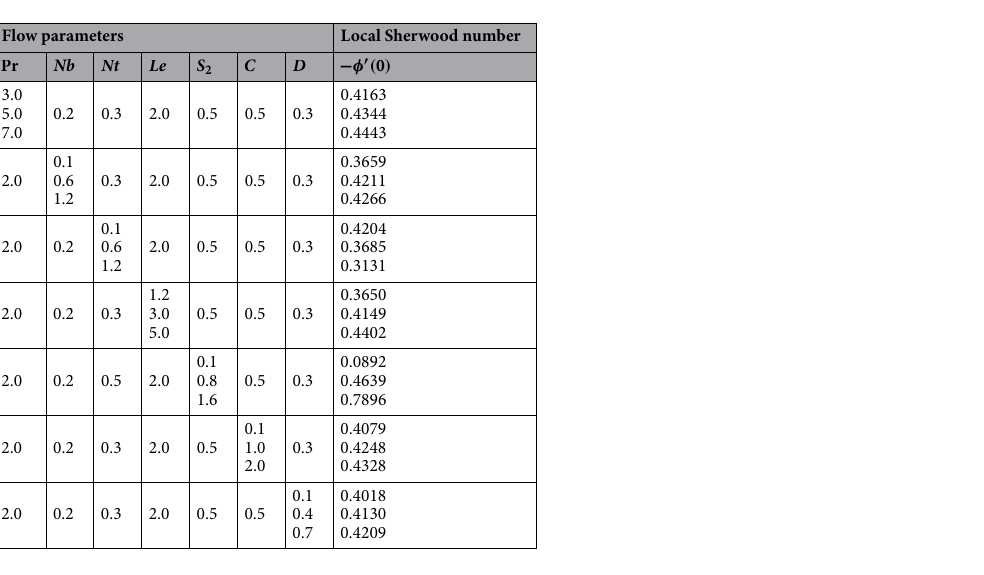
Table 3. Outcomes of